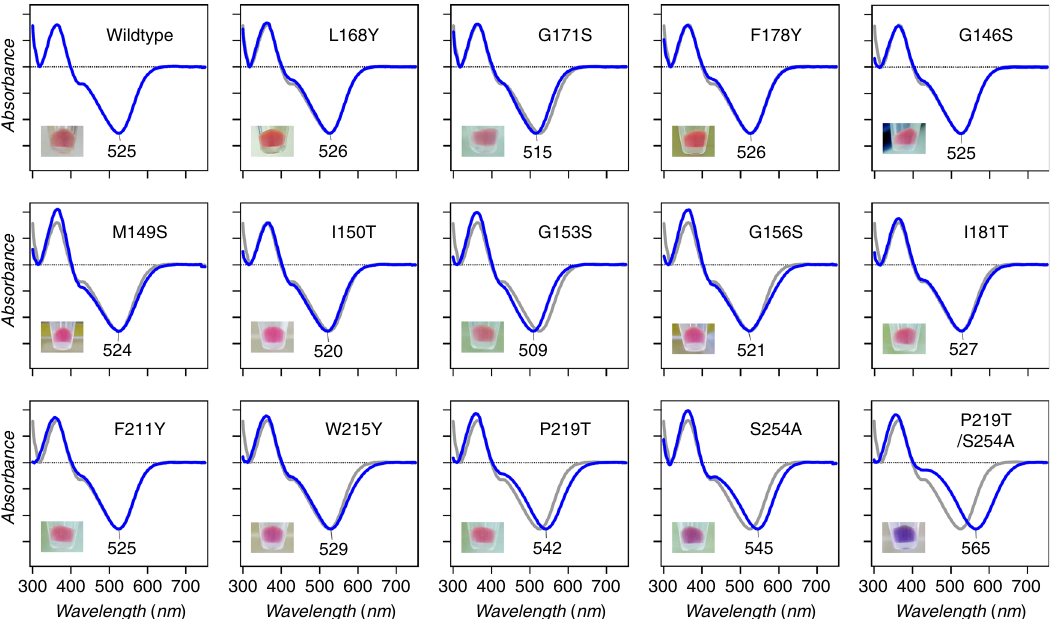
Fig. 2 λ max determination for KR2 mutants. Difference in ultraviolet – visible absorption spectra of the KR2 mutants before and after the bleaching reaction with hydroxylamine and pictures of the pellets of E. coli cells expressing the proteins. Source data are provided as a Source Data fi